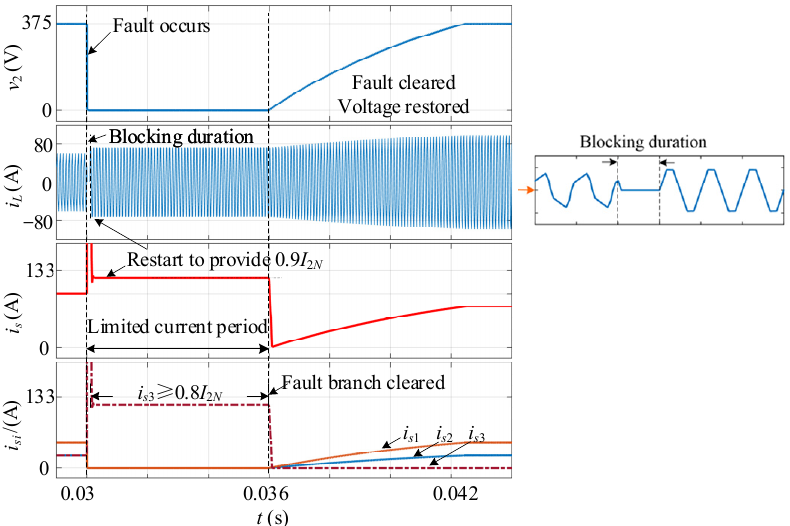
Figure 3. Simulation results of the FRT proposed in